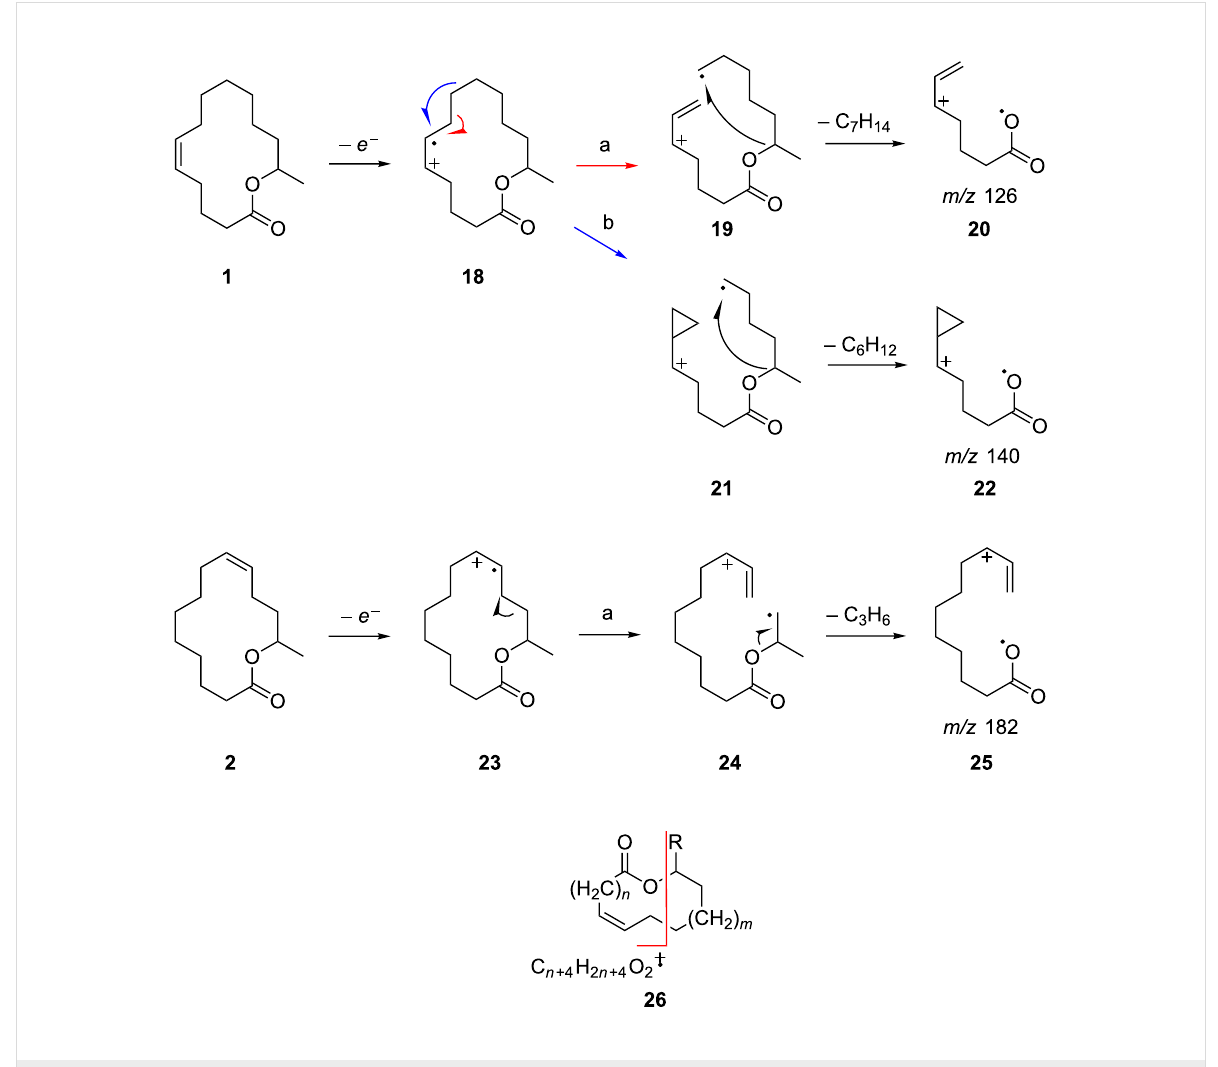
Figure 5: Proposed mass spectrometric fragmentation of macrolides 1 and 2 leading to diagnostic ions of the ion series C n H 2 n − 4 O 2 (C n +4 H 2 n +4 O 2 in the figure), indicating the position of the double bond in the ring.